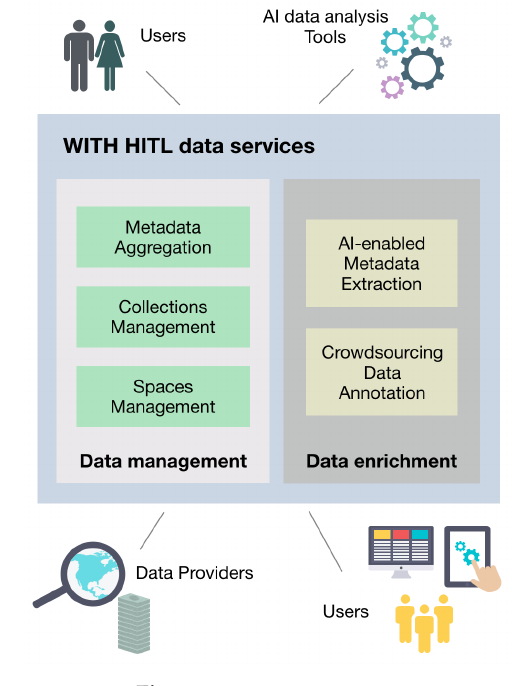
Figure 2. Platform overview.